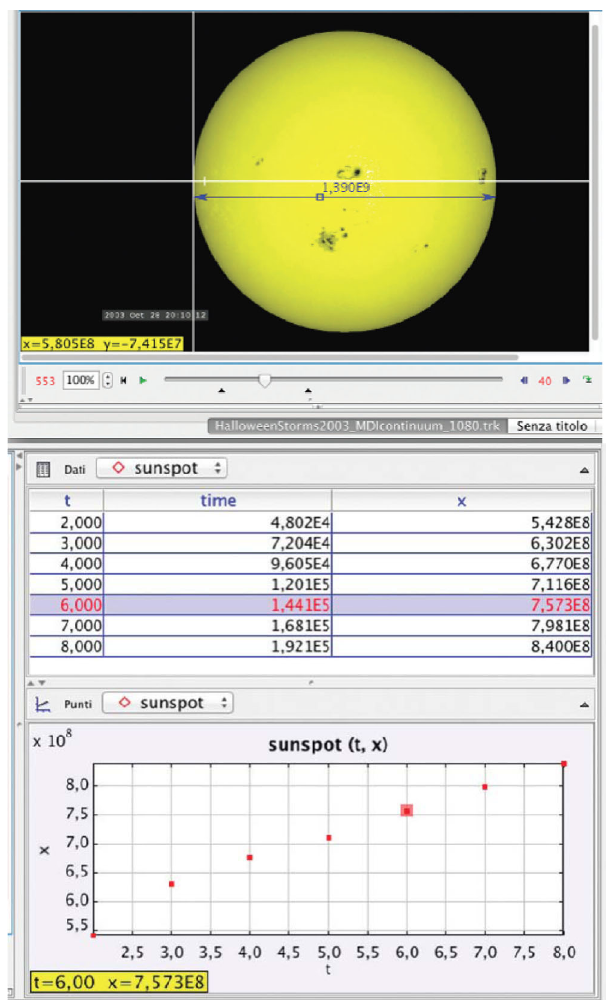
FIG. 7. Tracker screenshots on the measurement of Sun ’ s rotational velocity.